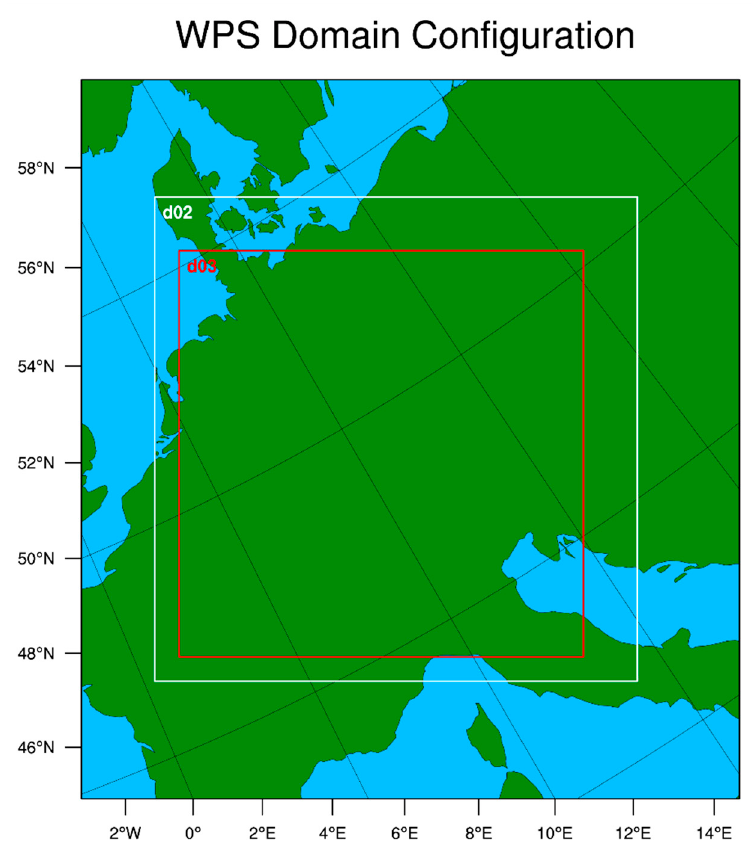
Figure 1. Weather Research and Forecasting (WRF) multi-nesting domain configuration approach with increasing domain resolution of 36, 12 and 4